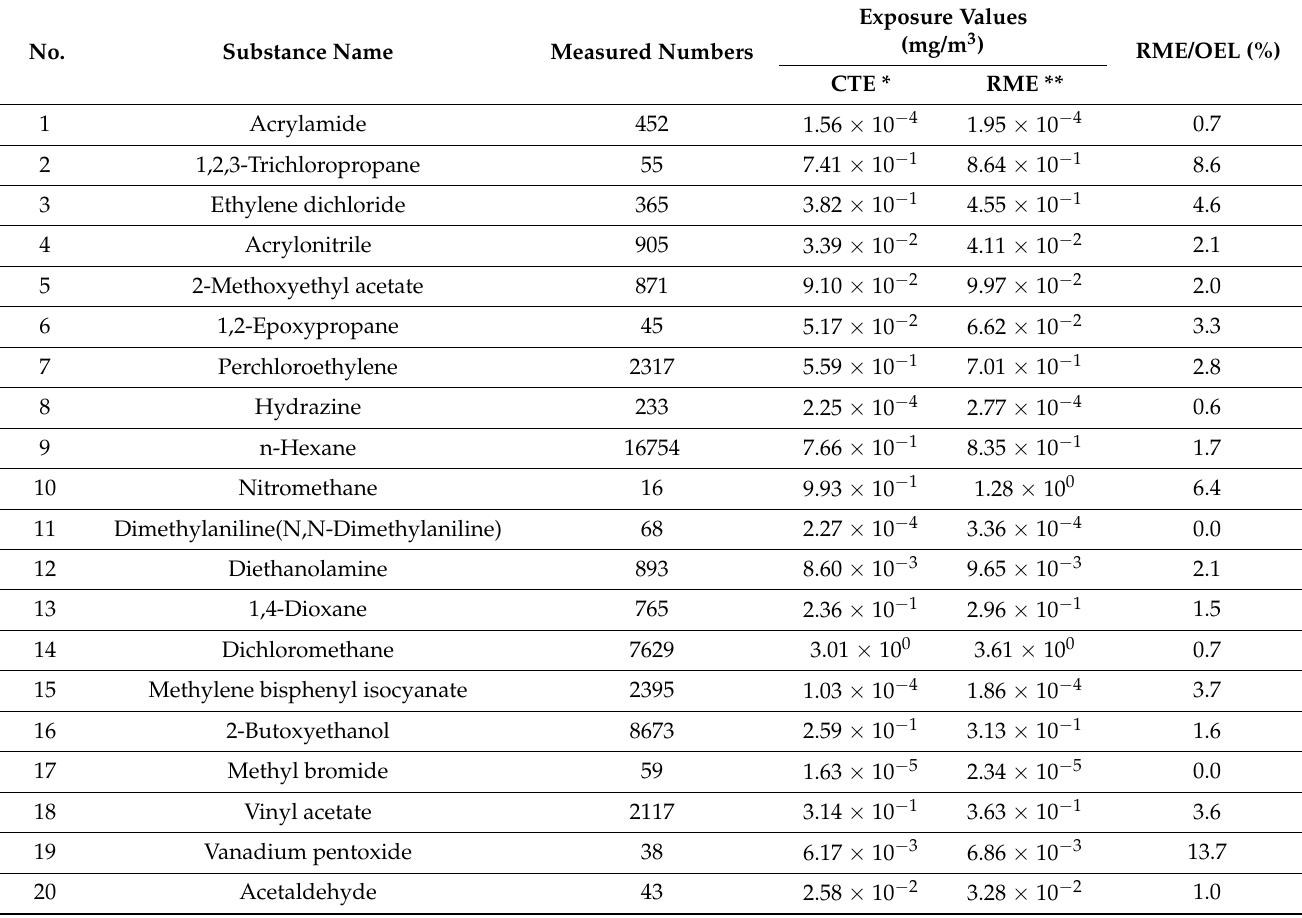
Table 4. Workplace environment measurement results of the target substances.